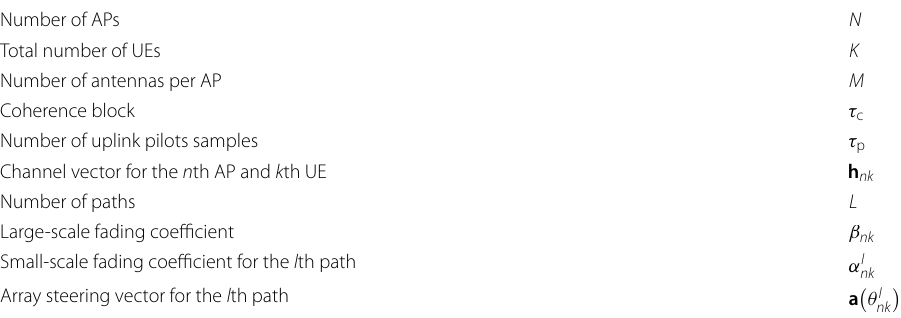
Table 1 System parameters Number of APs N Total number of